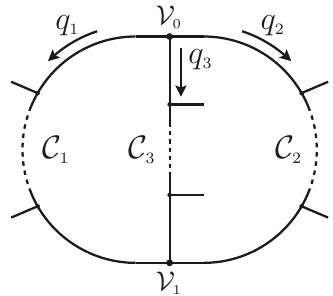
, , that connect three V 0 V 1 vertex should be V 0 is a V 0 p i 0 equal to i